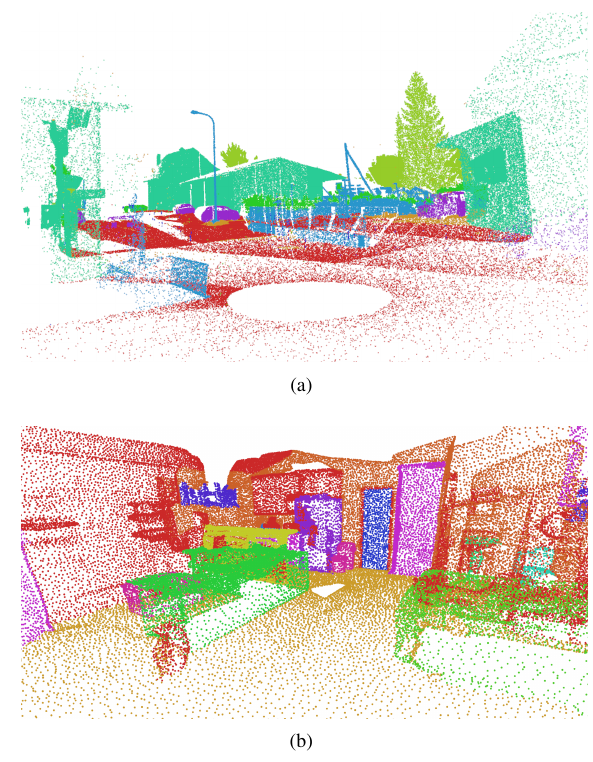
Figure 2. Point cloud classification results of a) Semantic3D and b) ScanNet datasets. Images are derived from inference of entire scene, which contains training, test and validation